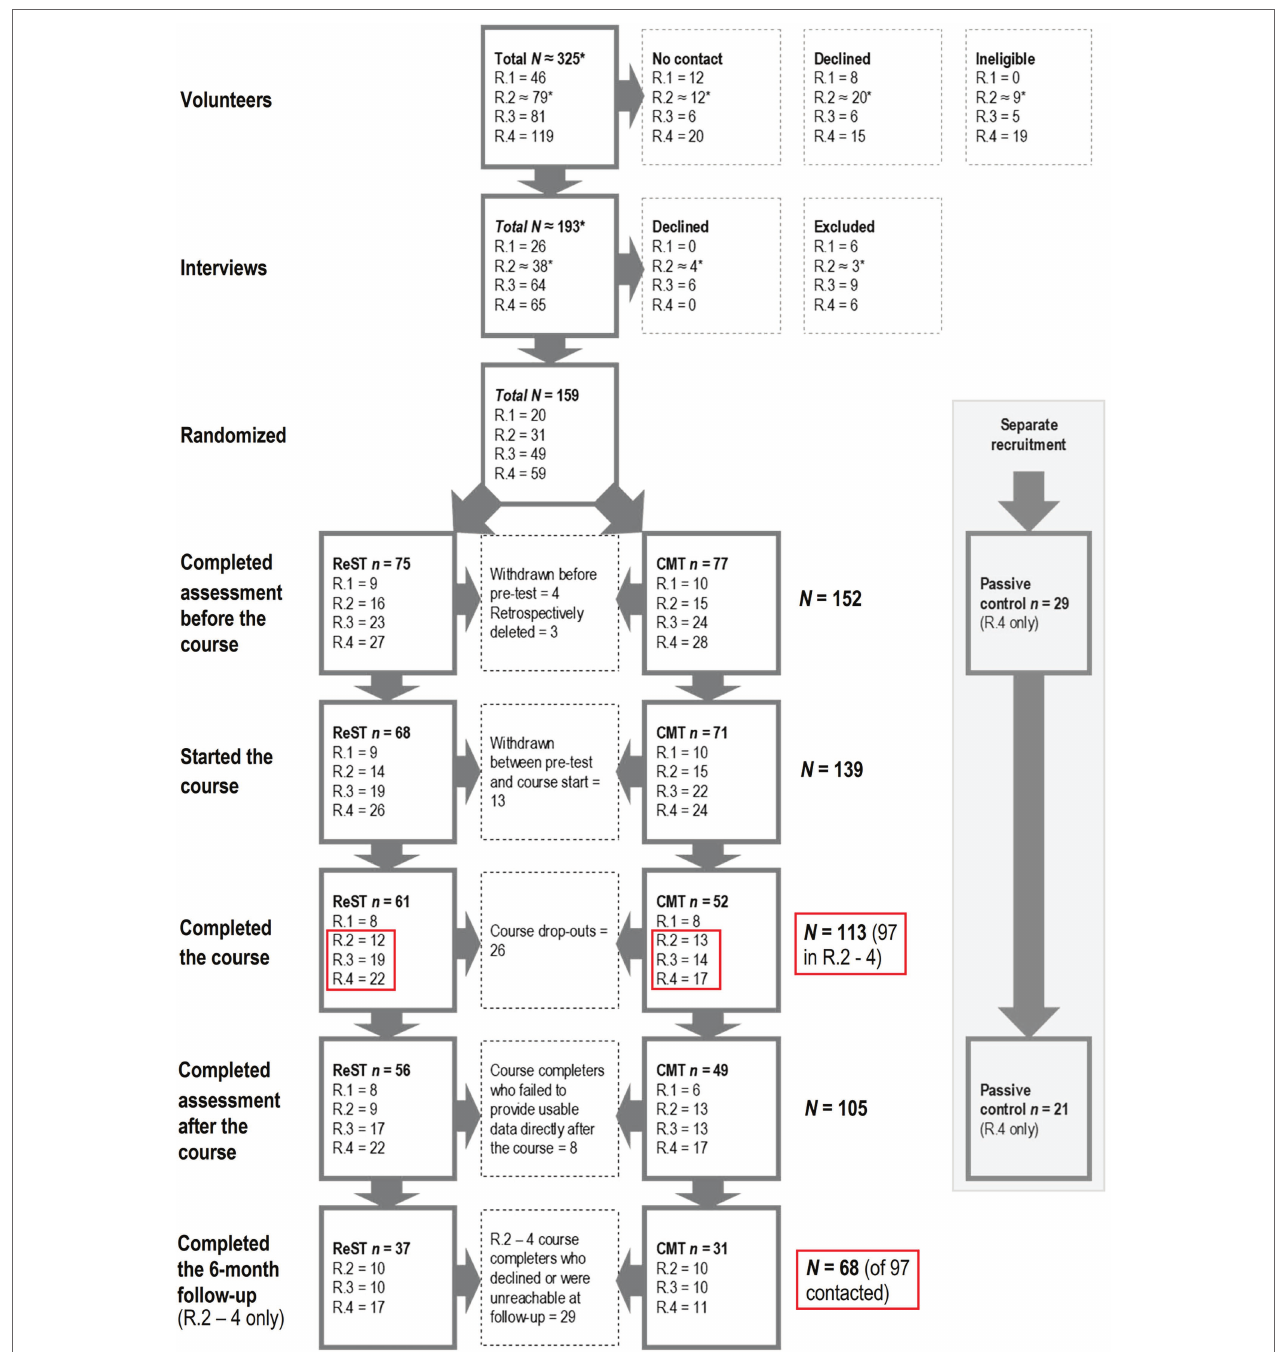
FIGURE 1 | Participant flow through the recruitment, interventions, and evaluations in the four data collection rounds of the study, where participants in rounds 2–4 were contacted for the 6-month follow-up. * denotes approximations necessitated by incompleteness of the records from early stages of the recruitment for data collection round